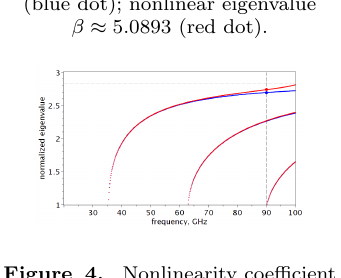
Figure 5. Nonlinearity coefficient α = 2 × 10 − 4 mm/V. Eigenfunctions. Blue dash line (linear problem) β ≈ 5 . 0815 and red line (nonlinear problem) β ≈ 5 .